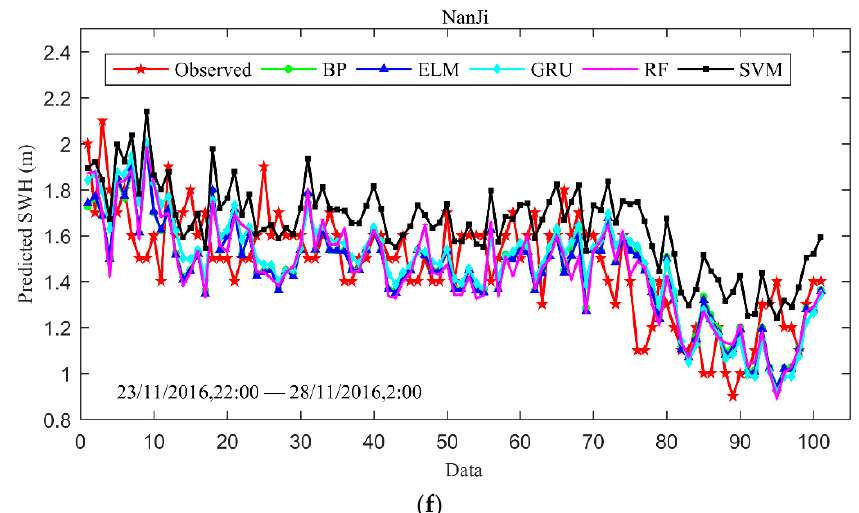
Figure 6. Comparison of five algorithms with lead times of 6 h at various stations: (a) station 46714D, (b) station 46735A, (c) station 46787A, (d) station C6V27, (e) station C6W08, (f) station NanJi.